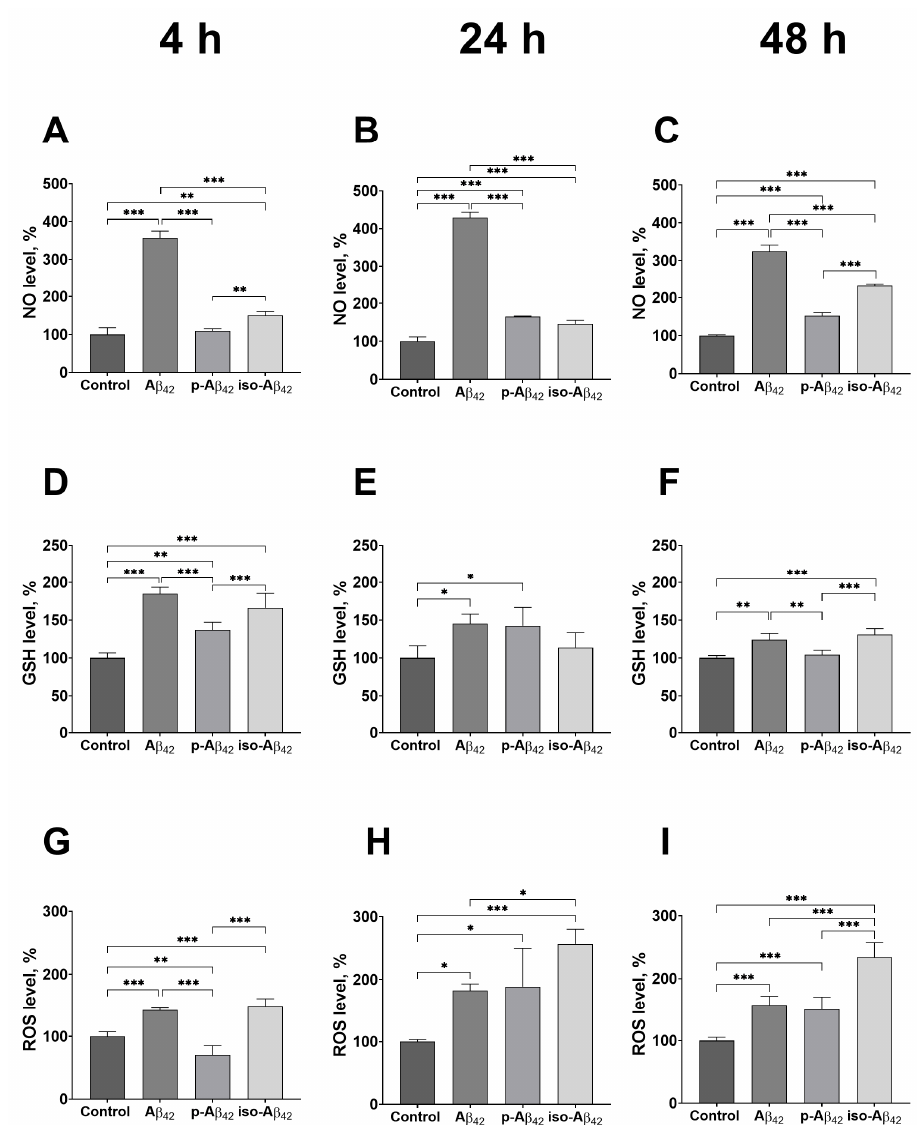
Figure 2. The effects of beta-amyloid isoforms on the redox parameters in bEnd.3 cells. Cells were incubated for 4 h ( A , D , G ), 24 h ( B , E , H ) and 48 h ( C , F , I ) with 10 µ M of A β 42 , p-A β 42 and iso-A β 42 . The level of intracellular nitric oxide (NO) ( A – C ), reduced glutathione (GSH) ( D – F ) and intracellular reactive oxygen species (ROS) ( G – I ) were analyzed by flow cytometry. All parameters were normalized to control. The values in the control samples were taken as 100%. The mean ± SD in 3 independent experiments in triplicates is shown in the figure. The statistical difference between experimental groups was analyzed by one-way analysis of variance using the post hoc Tukey test for multiple comparisons. *— p < 0.05, **— p < 0.01 and ***— p < 0.001.